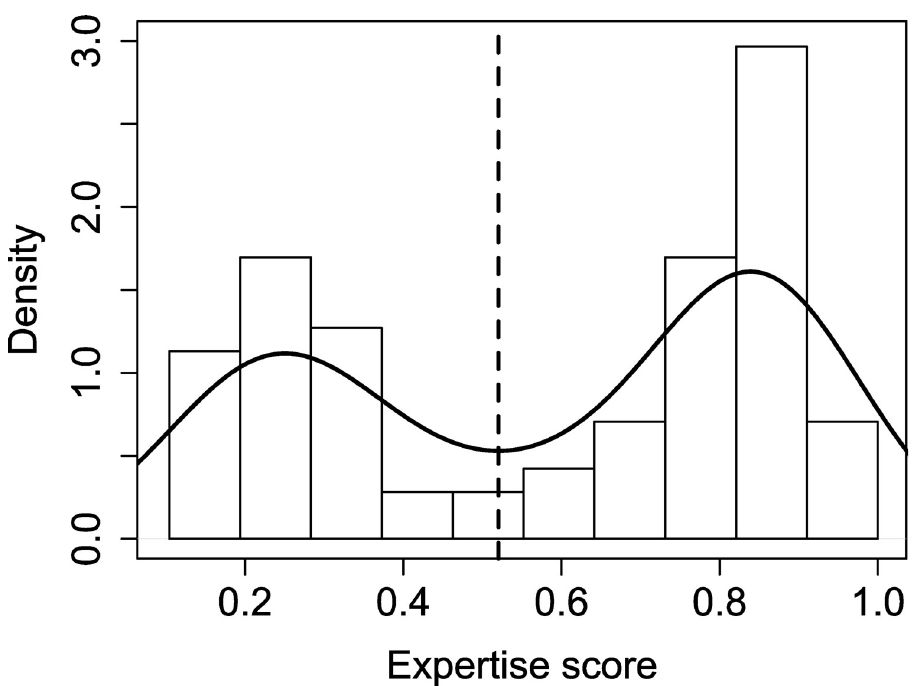
Fig 3. Density distribution of pre-test expertise scores. The expertise metric combined answers to questions about prior knowledge, self-perceived prior knowledge, amount of training and current occupation into an average score (S1 Table). Participants were divided into experts and novices based on the threshold at the local minimum of the distribution.